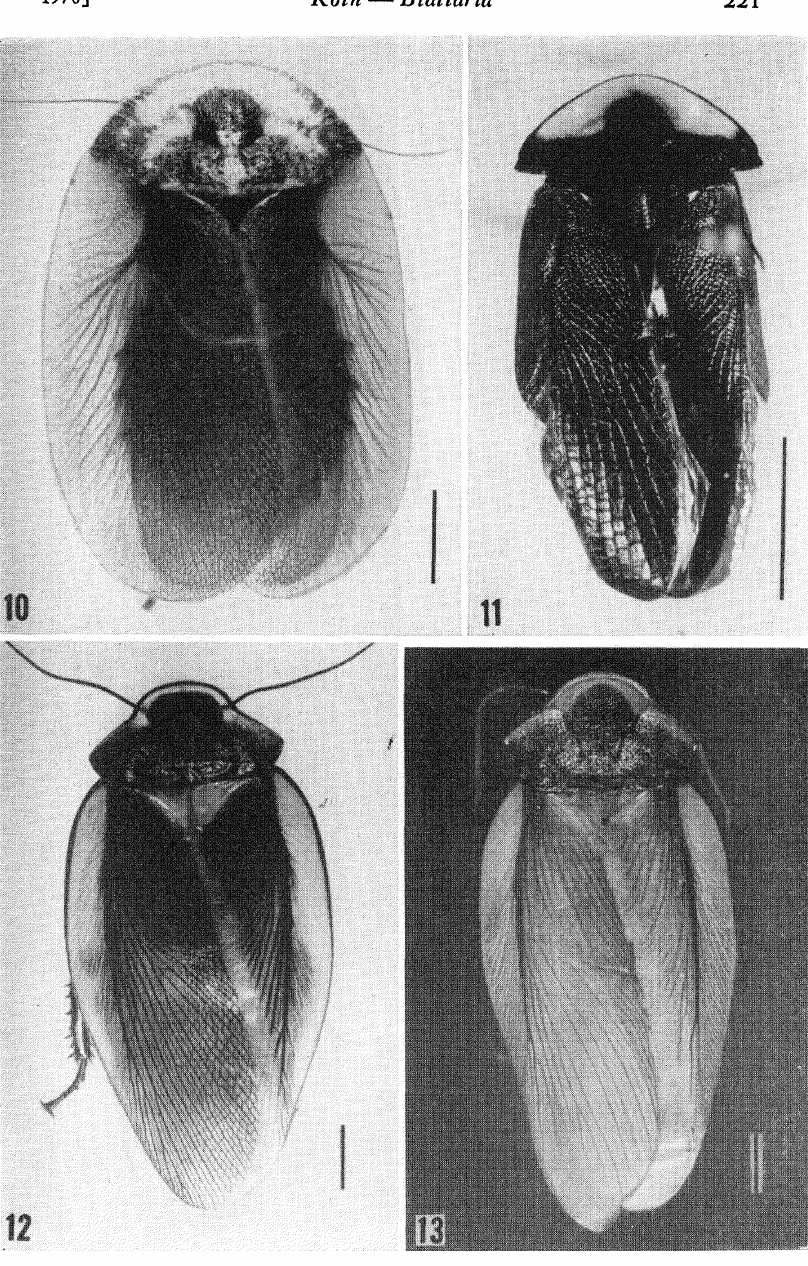
Figs. 10-13. 10. (N). Capucina p.atula (Walker). Costa Riea (det. Gurney). 11. (102 ANSP). Zetoborella gemmicula Hebard. Topotype. St. Jean du Maroni, French Guiana. 12. (N.) Phortioeca phoraspoides (Walker). Panama. (det. Gurney). 13. (98 ANSP). Phortioeca peruana Sauss. Marcapata, Peru. (scale